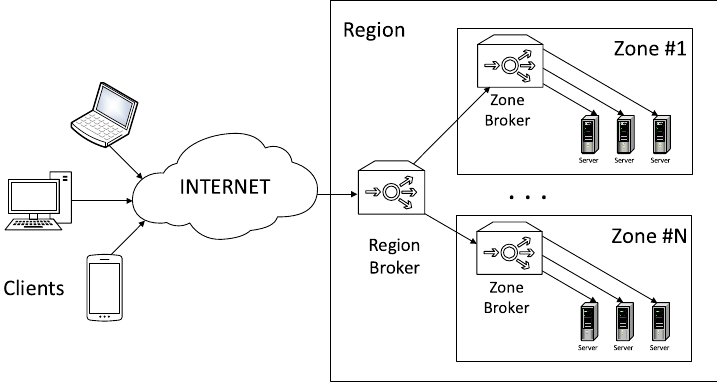
Fig. 1. The two-layer architecture of Web cloud